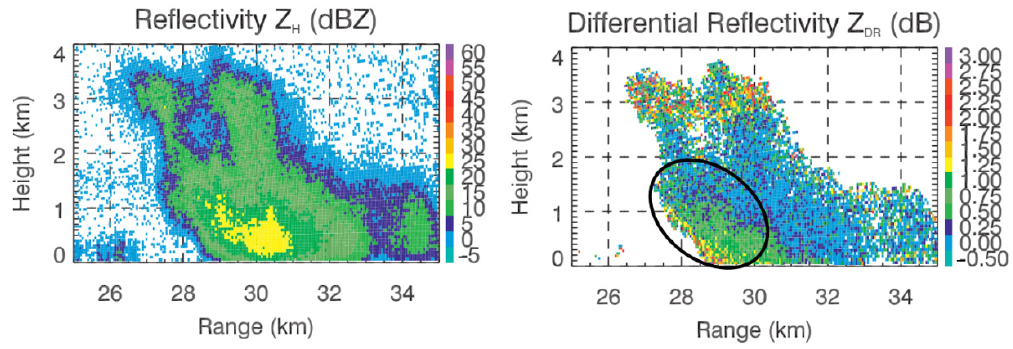
Figure 10. RHI scan of Z and Z DR taken at 0404 UTC 22 June 2011 from the Bonn X-band polarimetric radar. Adapted from Kumjian and Ryzhkov [84]. Used with permission from American Meteorological Society.